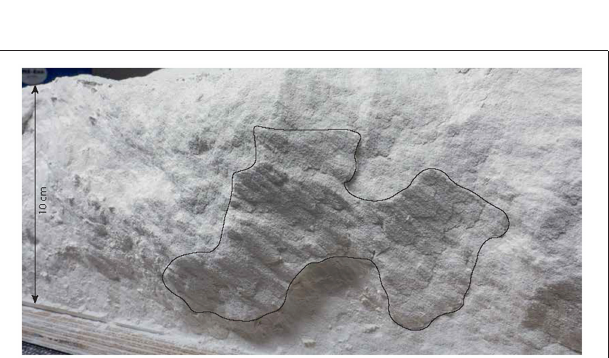
FIGURE 7 | Slickensides on an excavated fault surface of a hemihydrate experiment. Slickensides are best visible in the encircled area, and absent in dilatant parts of the